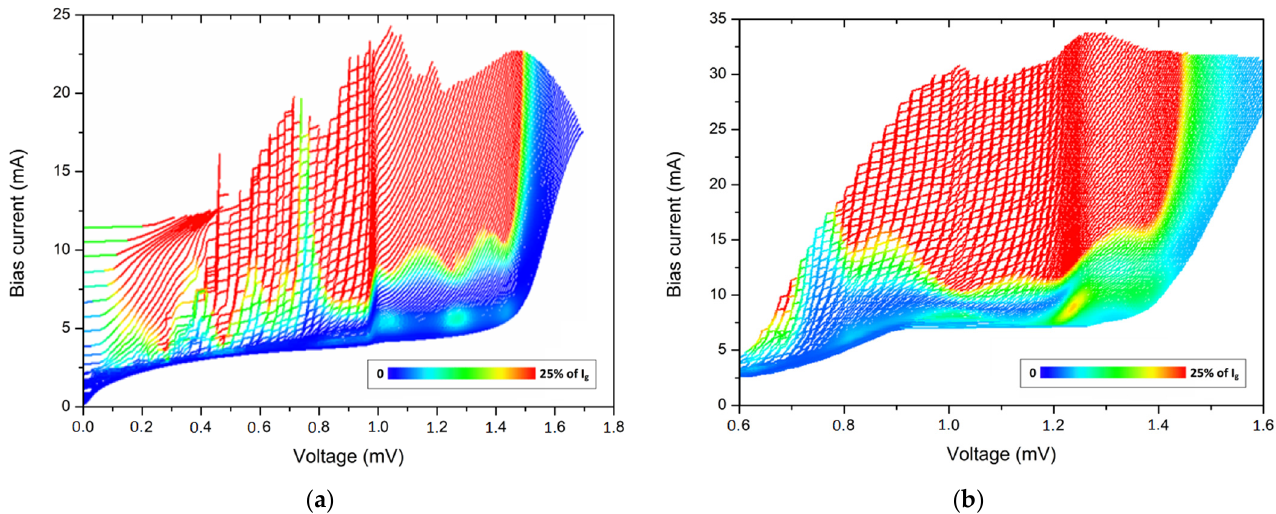
Figure 1. IVCs of the Nb/Al-AlO x /Nb ( a ) and the Nb/Al-AlN/NbN ( b ) FFOs, measured at different magnetic fields. The pumping current of the integrated SIS mixer induced by the FFO radiation is shown by the color.